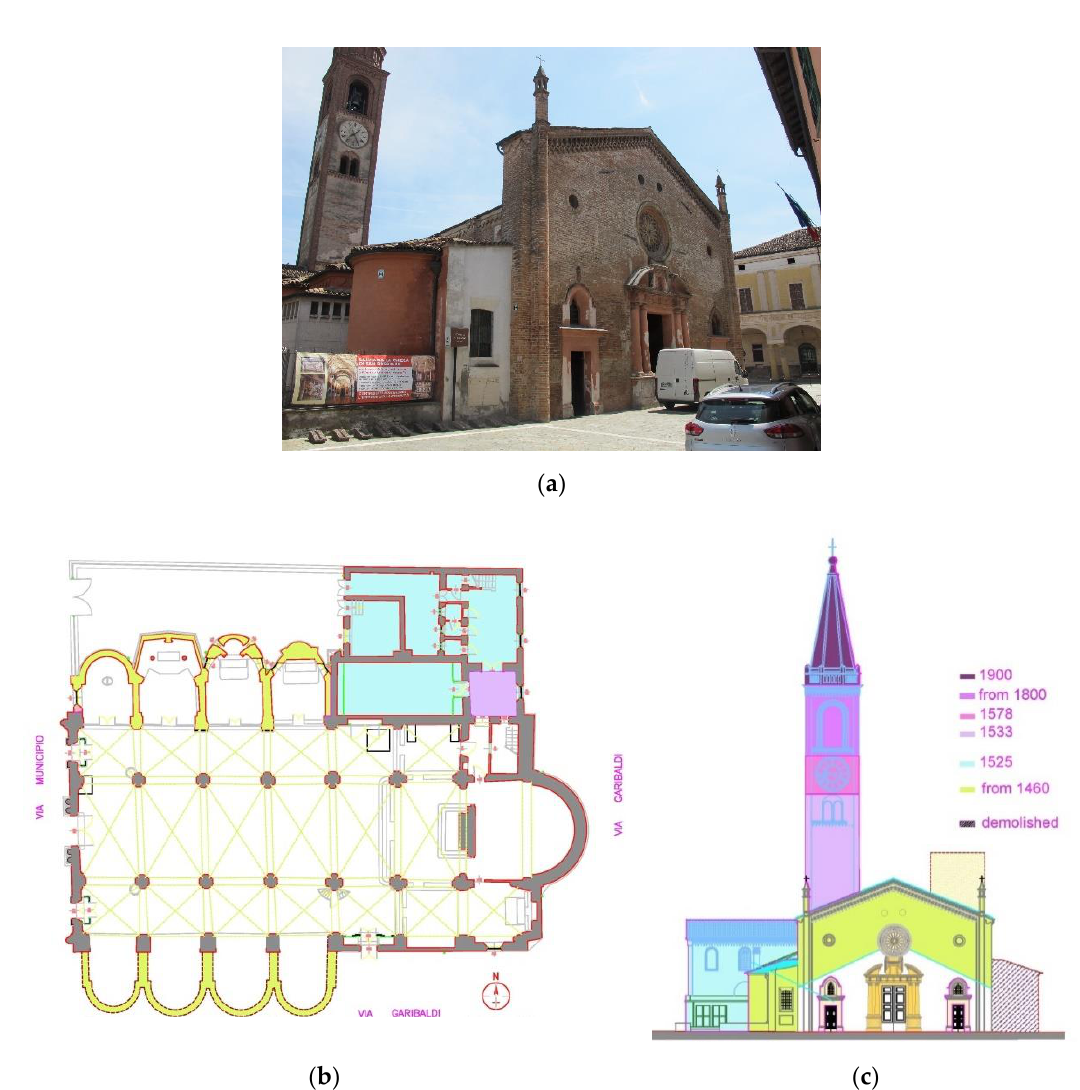
Figure 10. Historical evolution of the St. Bassiano church: ( a ) façade photo ( b ) historical evolution plan and ( c ) historical evolution elevation.